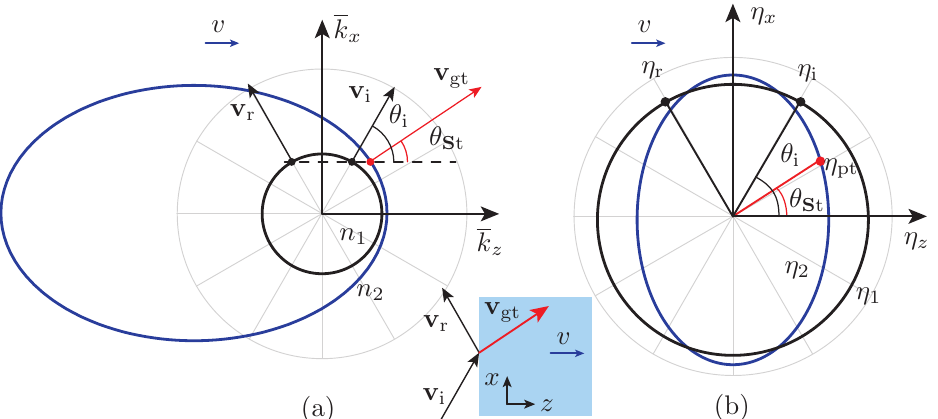
Figure 6. Graphical solution for the subliminal co-directional regime, for p-polarization, with v = 0.6 c and θ i = 60 ◦ . ( a ) Refractive index diagram. Inset: scattering in space; ( b ) Impedance